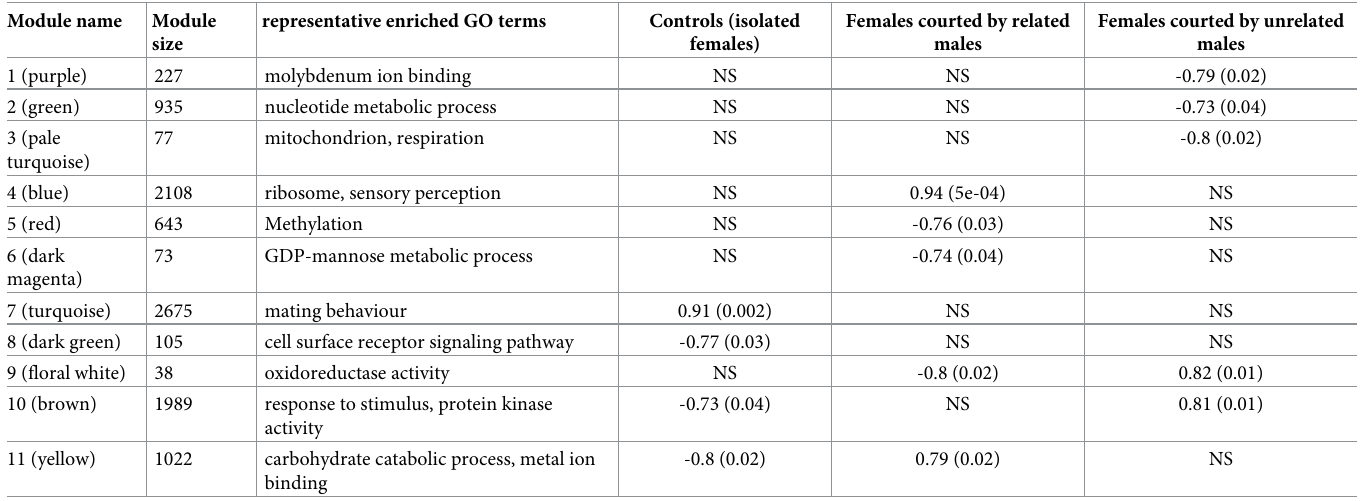
Table 1. Significant correlations between 11 modules and courtship experienced by